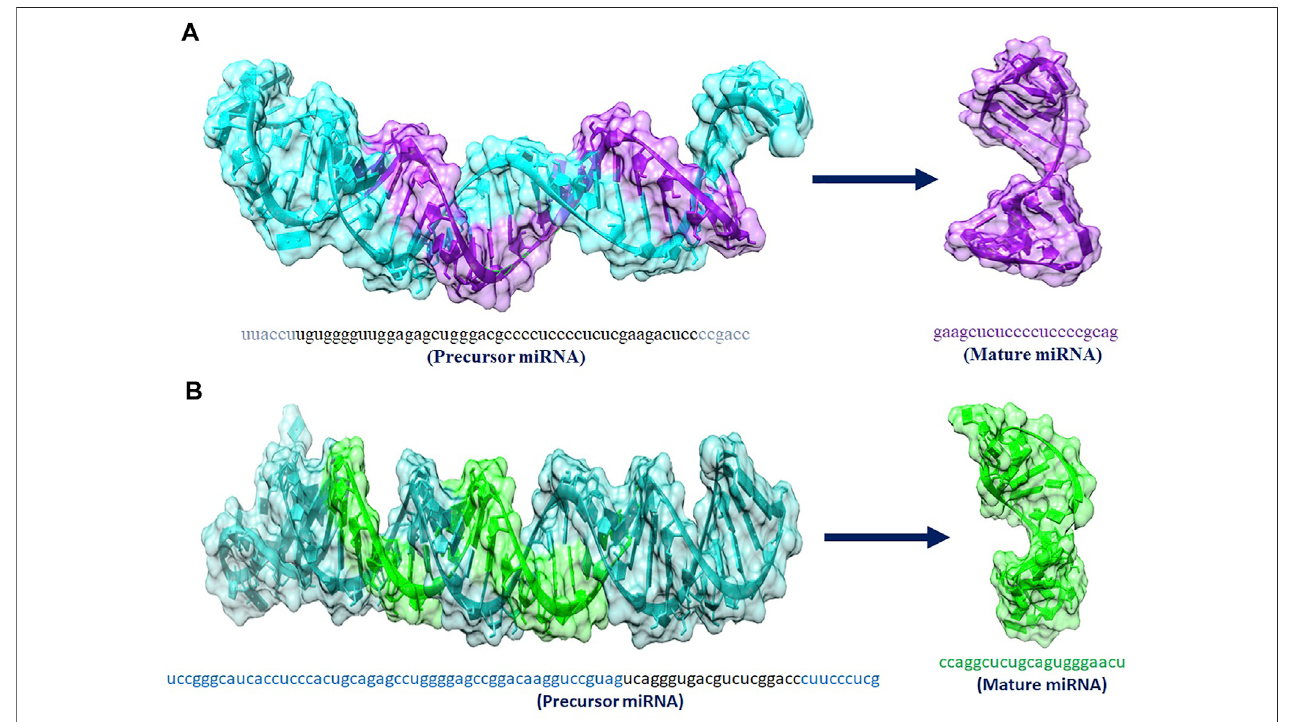
FIGURE 8 | (A , B) 3D structures of premature and mature miRNAs hsa_mir_6796-5p and has_mir_3155a, miRNAs